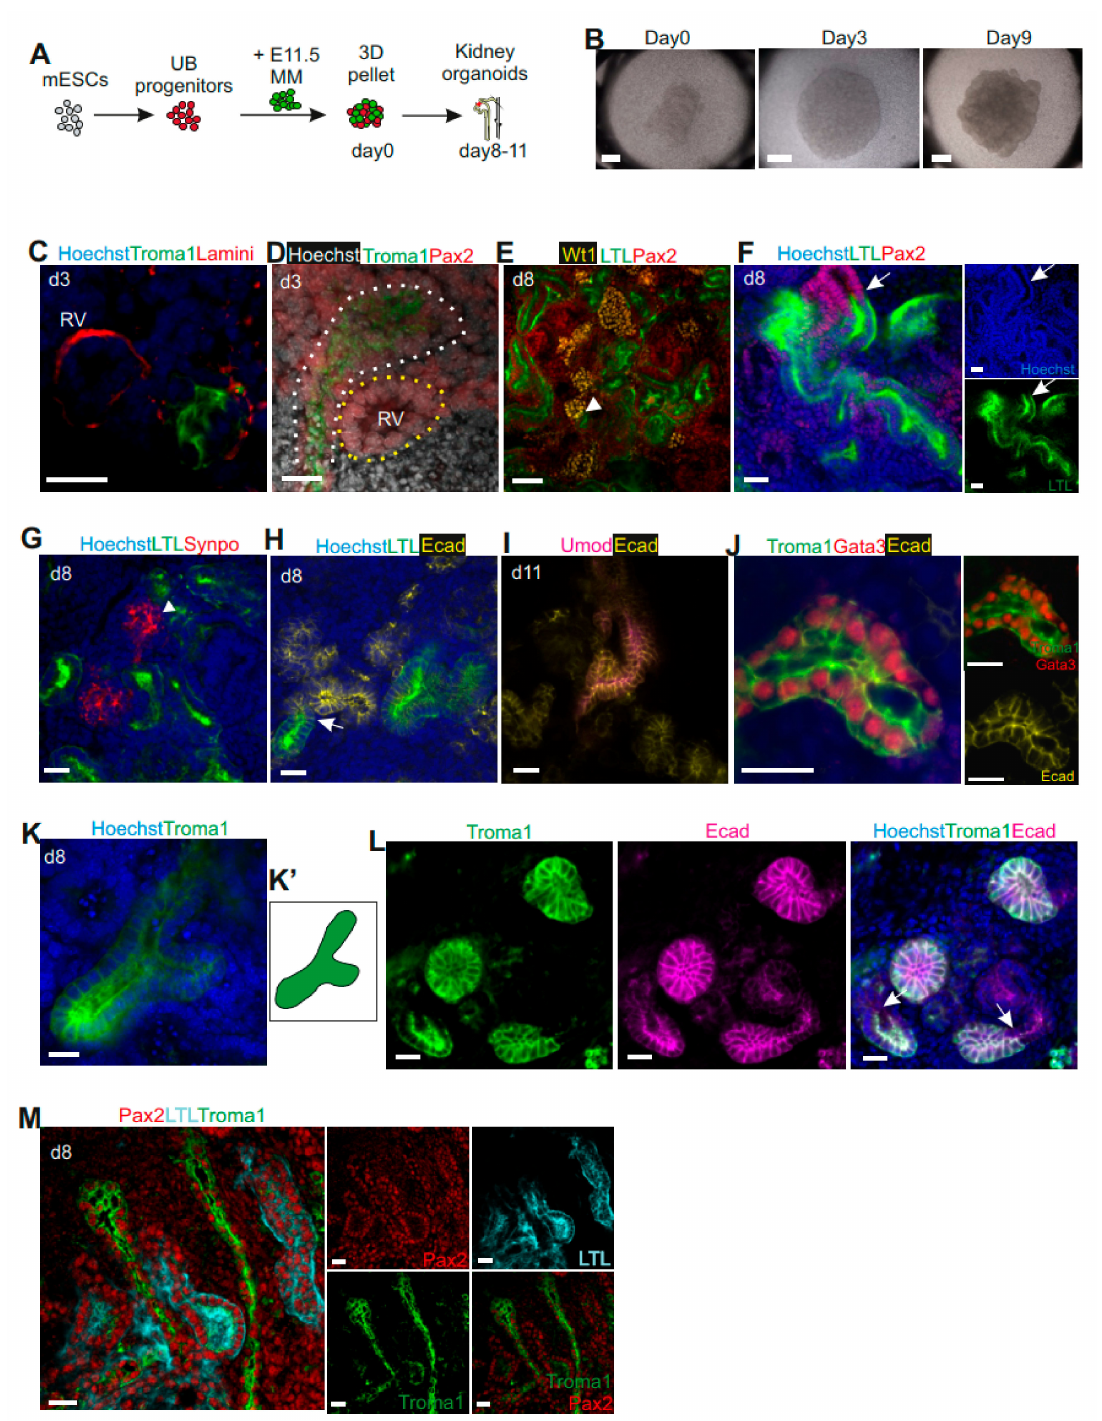
Figure 2. Generation of renal organoids by mESC-derived UB progenitors and primary metanephric mesenchyme (pMM) cells. ( A ) Schematic of generation of kidney organoids from mESC-derived UB progenitors with mouse E11.5-dissociated pMM. ( B ) Global bright field images of self-organizing kidney organoids in a Trowel organ culture system. Scale bars, 500 µ m. ( C ) Immunofluorescence